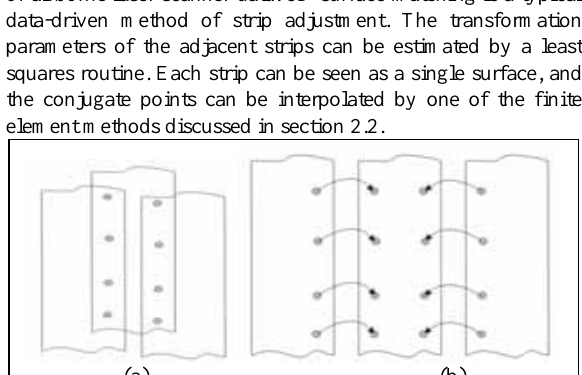
Figure 2. Surface matching for laser scanning strips: (a) overlapping area on conjugate surfaces, (b) Estimating